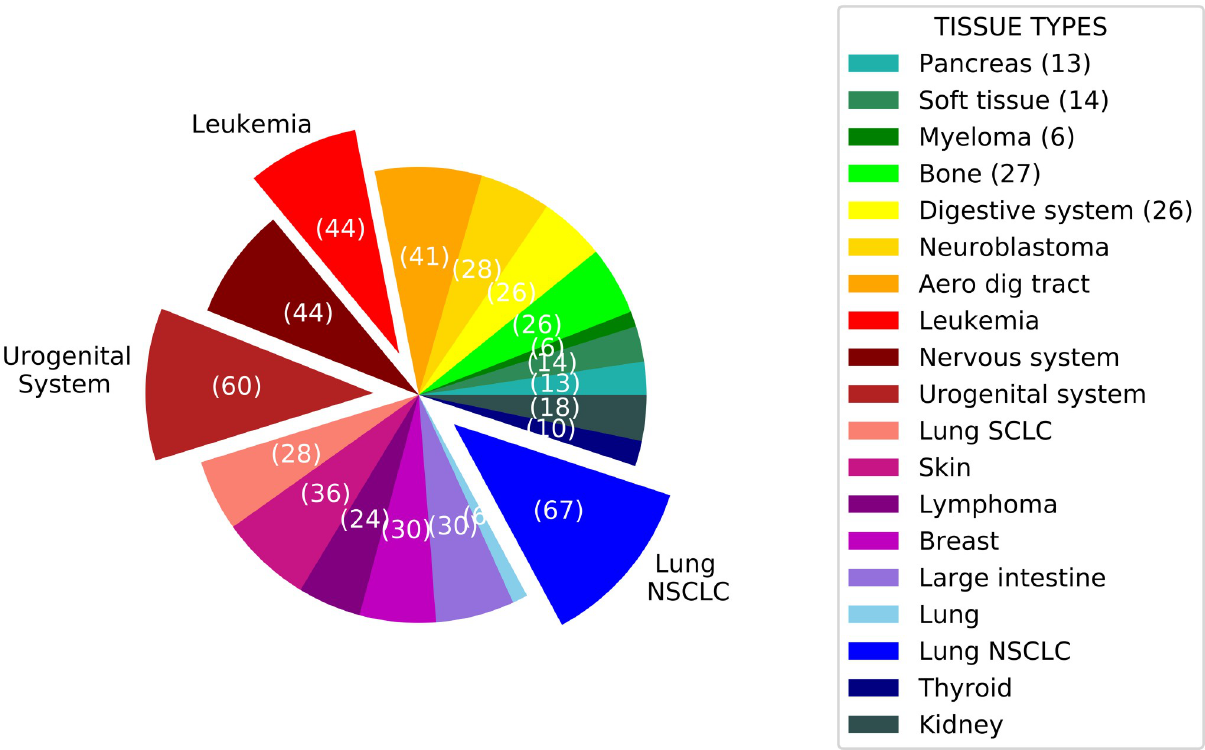
Fig 7. The number of cell lines in each tissue type. The number shown on slices is the number of cell lines in the related tissue type. Three major tissue types are the offset slices.